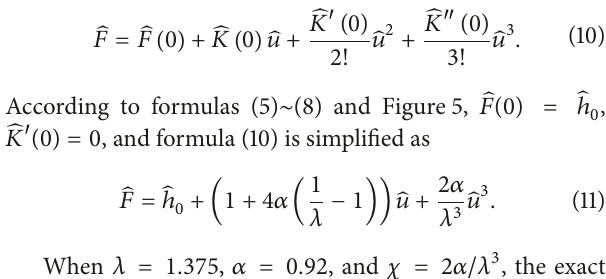
with the approximate relation of dimensionless force dis-